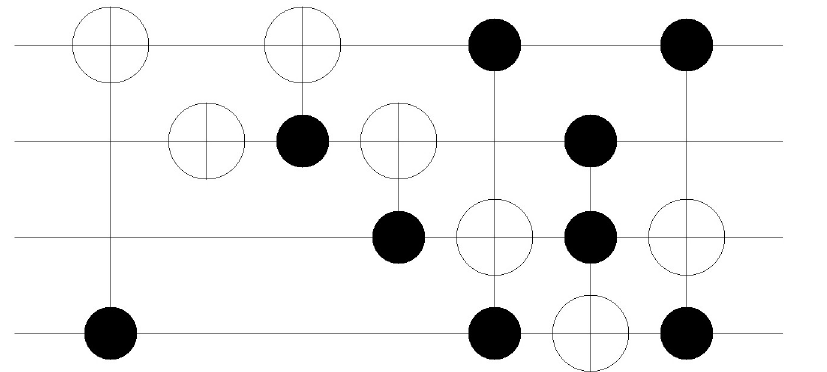
Fig 13. Resulting circuits of No. 18 mini_alu with varying N